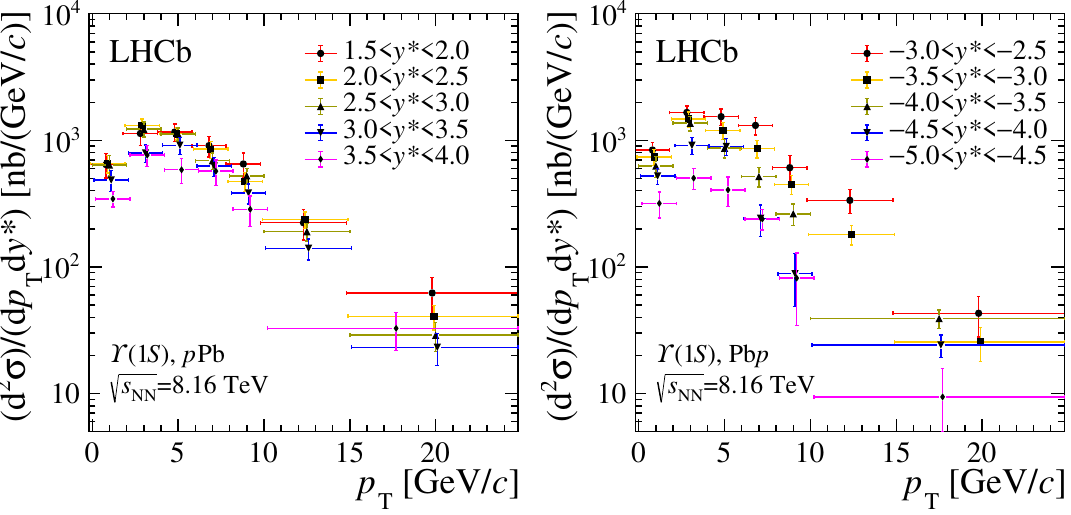
Figure 3 . Double-di(cid:11)erential cross-section for the (cid:7) (1 S ) meson as a function of p T for di(cid:11)erent values of y (cid:3) for the (left) forward p Pb and (right) backward Pb p samples. The uncertainties are the sums in quadrature of the statistical and systematic components. The horizontal locations of the markers are roughly the centroids of the bins, with o(cid:11)sets from centre to aid in readability.